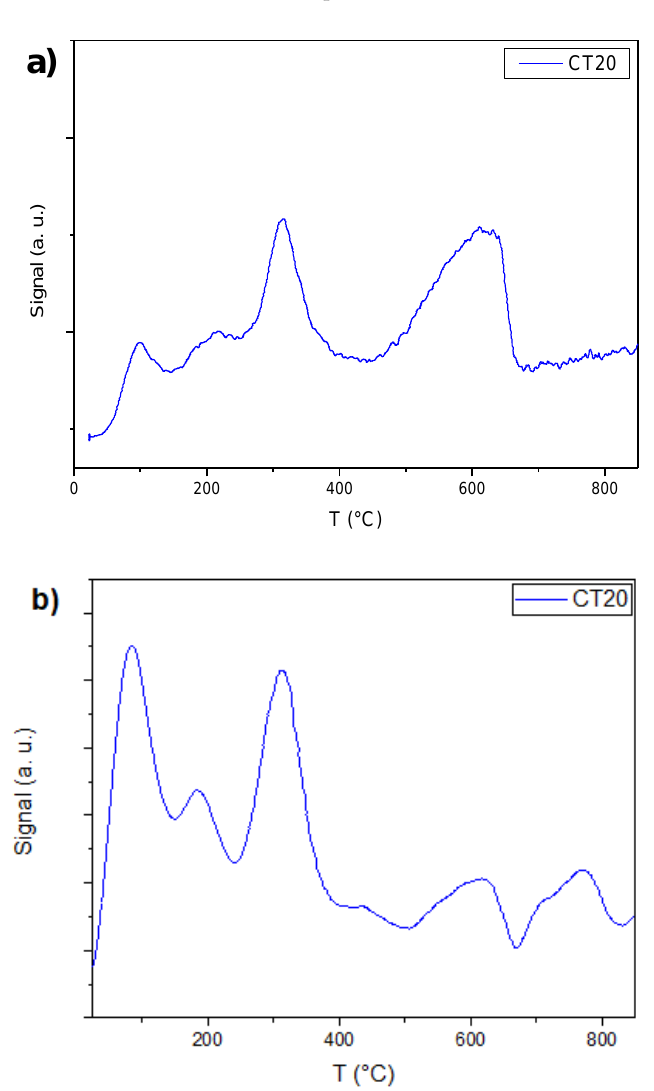
Figure 10. He-TPD of CT20 ( a ) before and ( b ) after exposure to a CO 2 -rich environment for 1 h at room temperature.